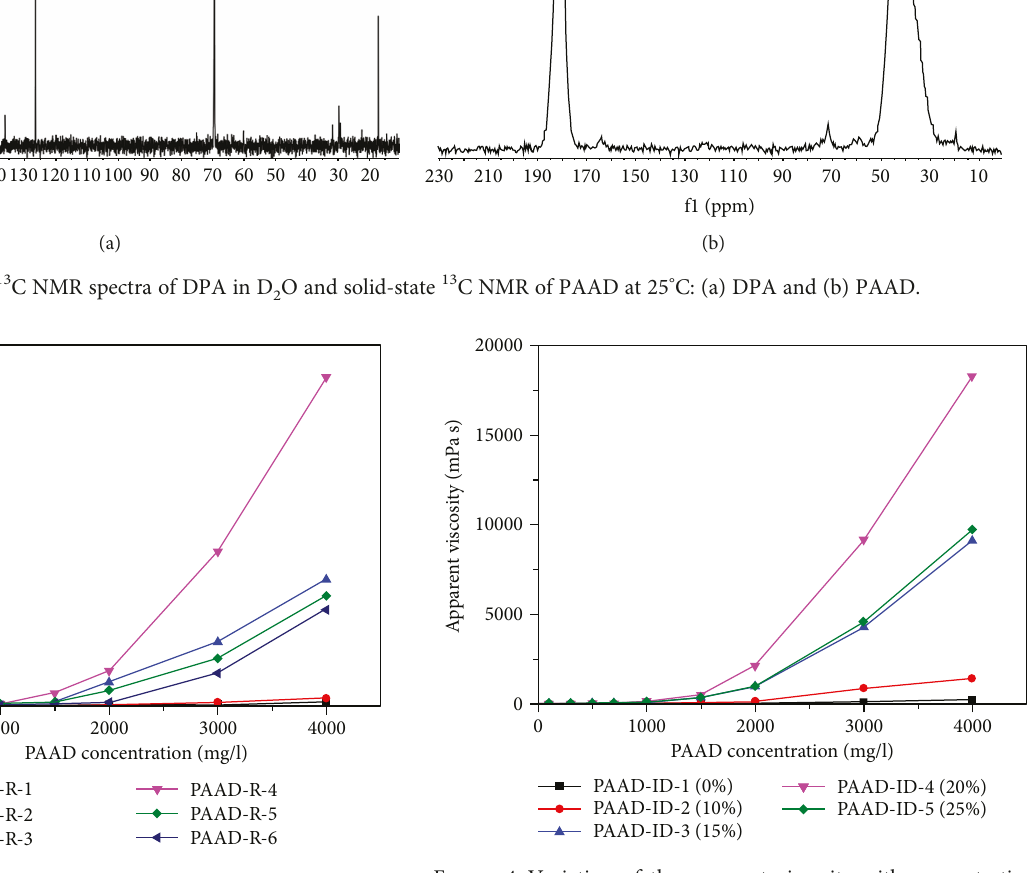
Figure 3: Variation of the apparent viscosity with concentration of PAAD at the shear rate of 0.6s − 1 in water with the NaCl concentration of 1000 mg/l at 25 ° C.